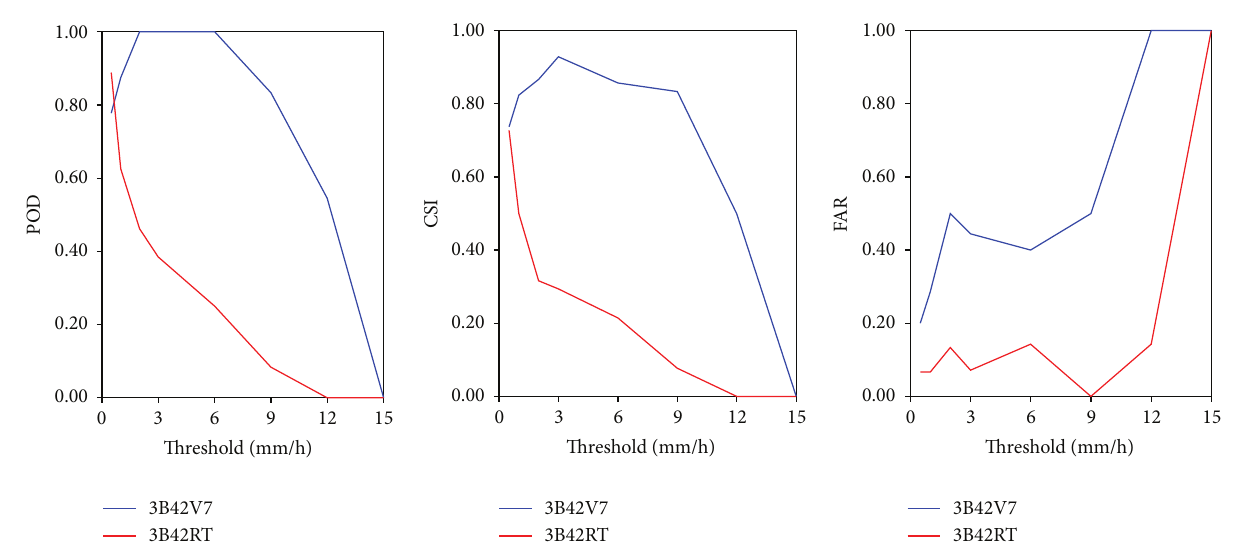
Figure 6: Categorical statistics of 3B42V7 and 3B42RT for POD, CSI, and